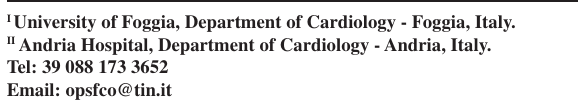
Figure 1 - Transthoracic two-dimensional visualization of the mass: parasternal long axis view and apical four-chamber view (upper panels). Transesophageal visualization of the mass (lower panels)